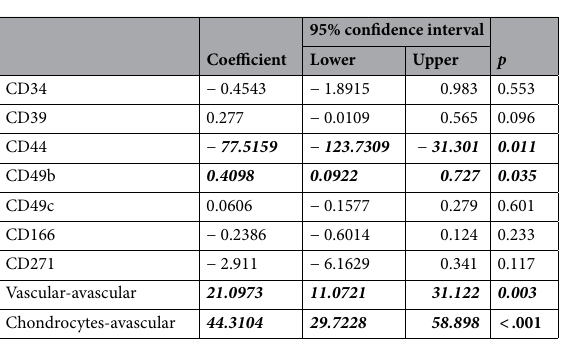
Table 3. Multilevel modelling. The significant values are highlighted in bold and